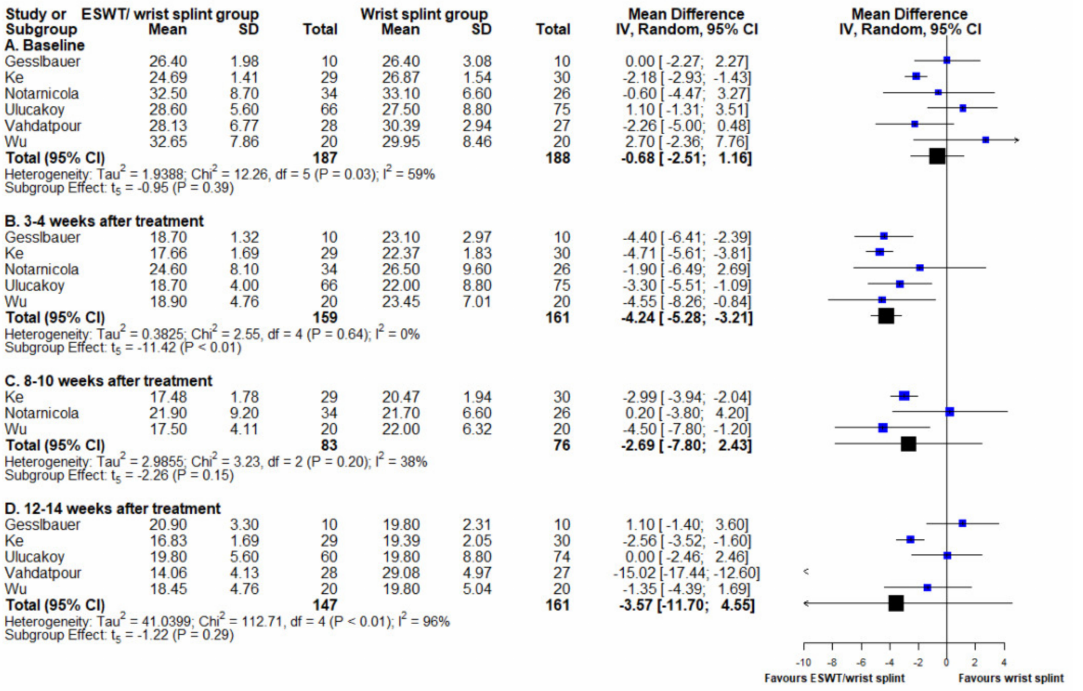
Figure 4. Forest plot of mean difference in BCTQs score between ESWT/night wrist splint and night wrist splint alone groups. Mean difference and standard deviation of each enrolled study and the meta-analysis results were presented as blue and black squares at the left column of the figure, respectively. BCTQs score at (A) baseline, (B) 4 weeks after intervention, (C) 8–10 weeks after intervention, and (D) 12–14 weeks after